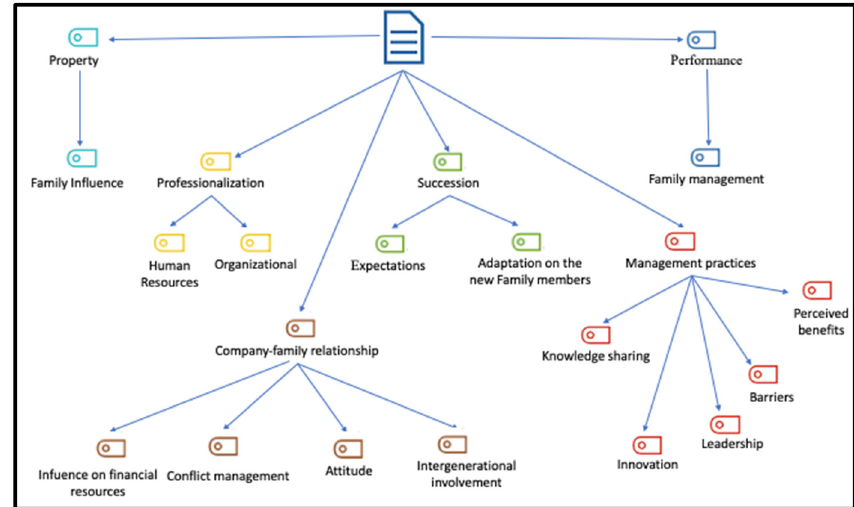
Figure 2. Global category map. Source: elaborated by the authors.